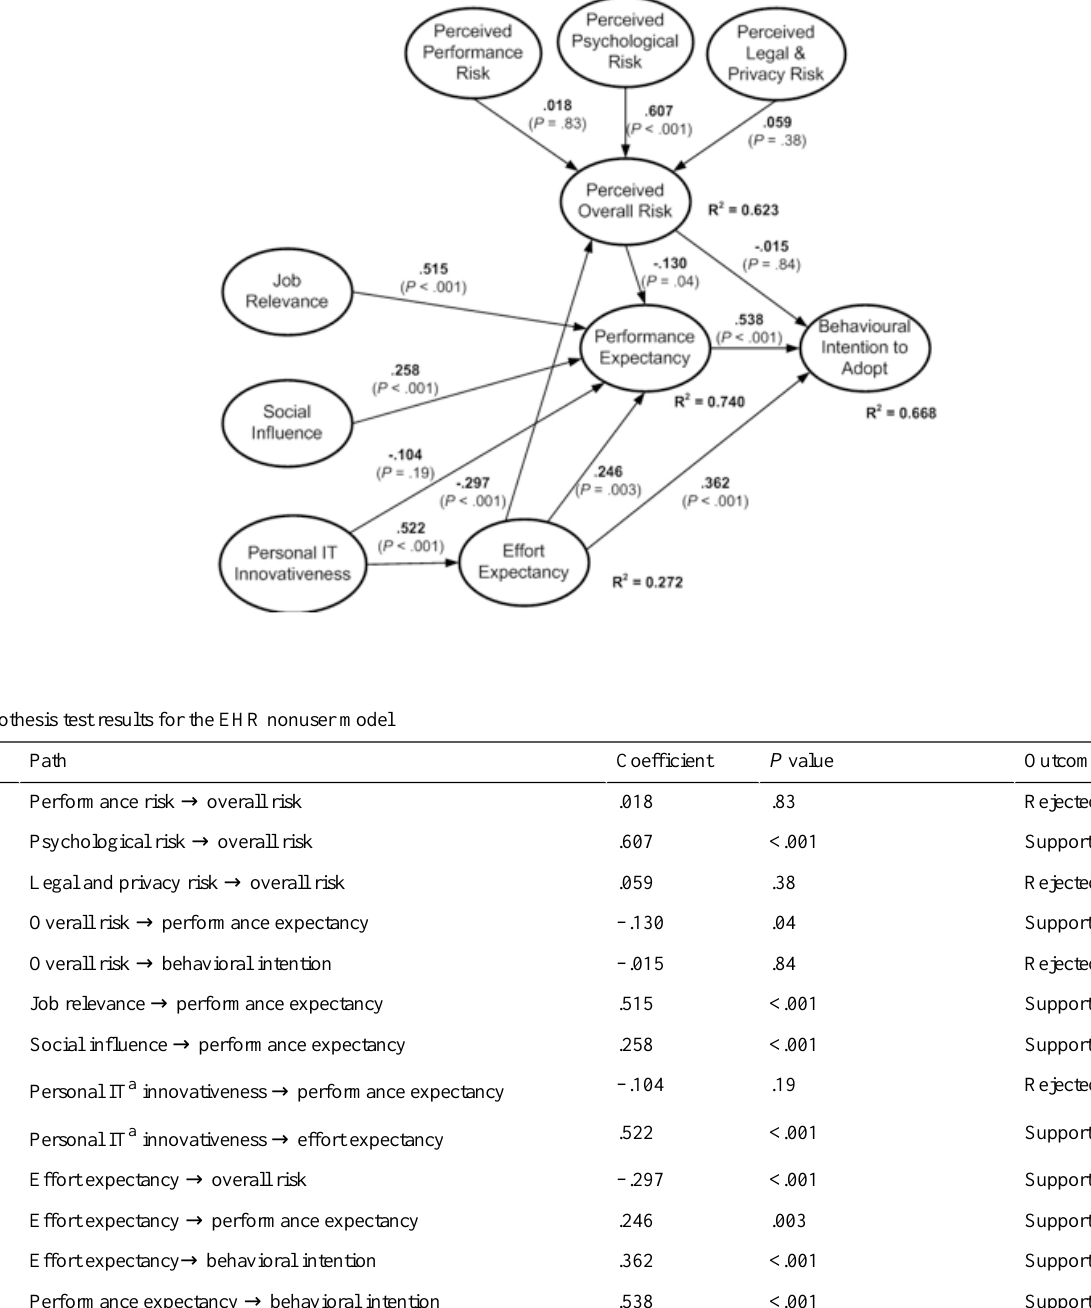
Figure 3. Structural evaluation of the electronic health record nonuser model